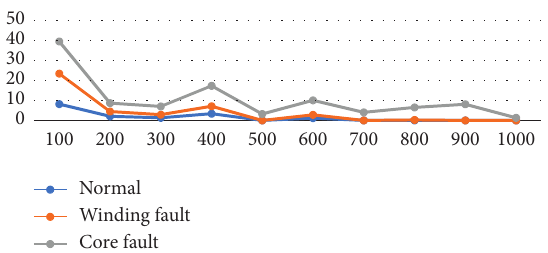
Figure 6: Comparison of frequency amplitude before and after